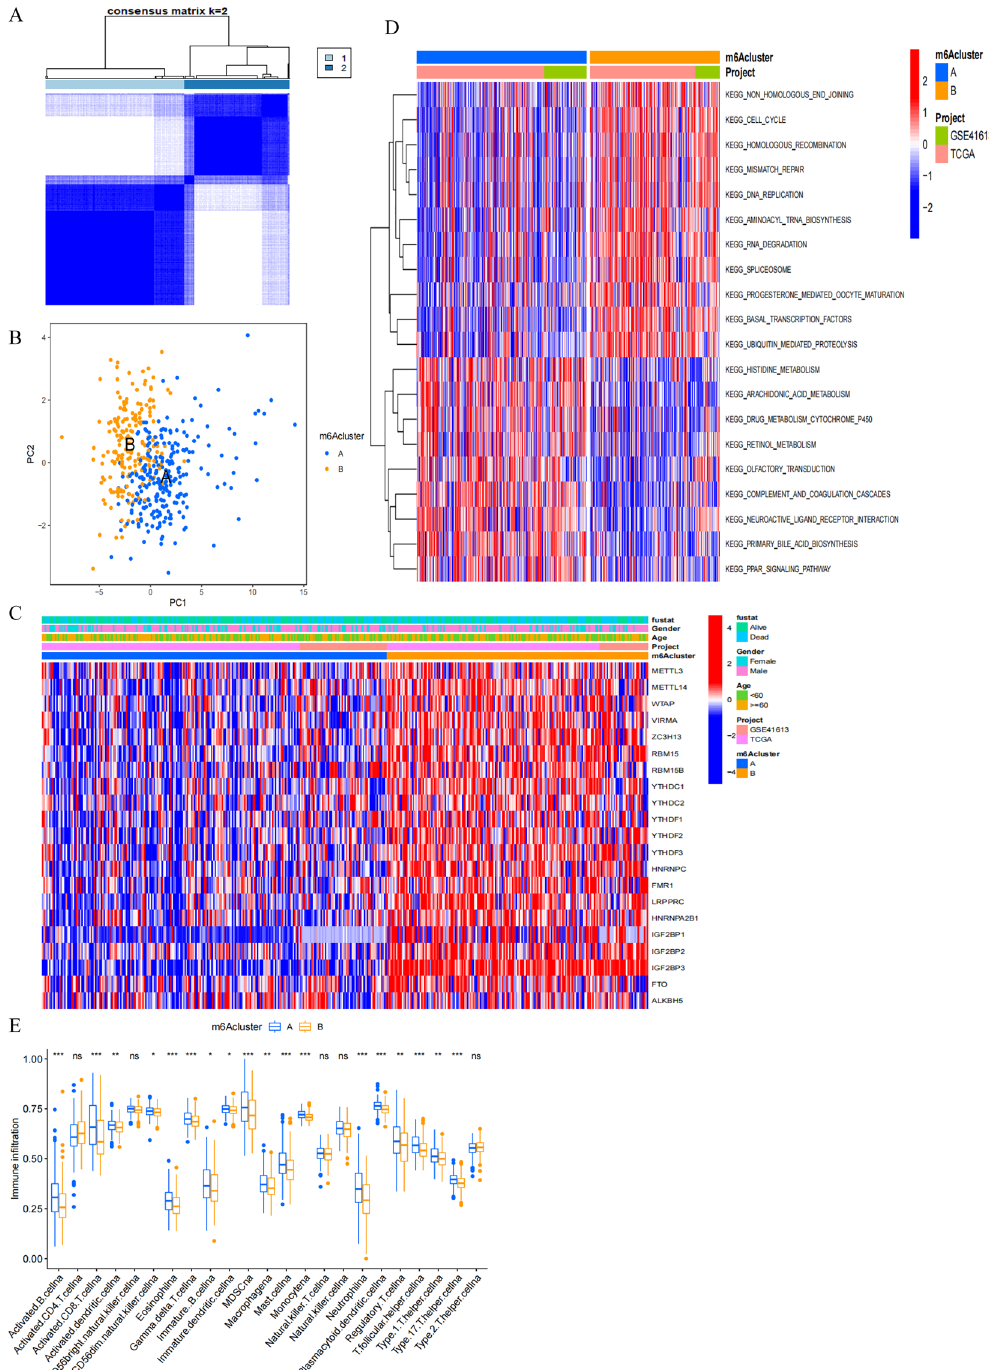
Figure 3. Characteristics of m 6 A methylation modification patterns. ( A ) Consensus clustering analysis of m 6 A regulators. Consensus clustering matrix for k = 2. Cluster A, 1; Cluster B, 2. ( B ) PCA analysis of m 6 A regulators. Samples in cluster A, blue dots; Samples in cluster B, yellow dots. ( C ) Unsupervised clustering of m 6 A regulators in OSCC patients from TCGA and GSE41613 cohort. Fustat, gender, age, project and m 6 Acluster were used as patient annotations. High expression, red; low expression, blue. ( D ) The heatmap of GSVA showing KEGG pathways in each m 6 A modification patterns. Red represented activated pathways and blue represented inhibited pathways. KEGG pathways 14–16 were downloaded from the website (http:// www. gsea- msigdb. org/). ( E ) ssGSEA of immune cells infiltration in individual m 6 A modification patterns. Cluster A, bule; Cluster B, yellow. Top edge of box: upper quartile; bottom edge of box: lower quartile; Internal horizontal line: median. Dots above and below: outliers. *p < 0.05; **p < 0.01; ***p < 0.001; ns no statistical